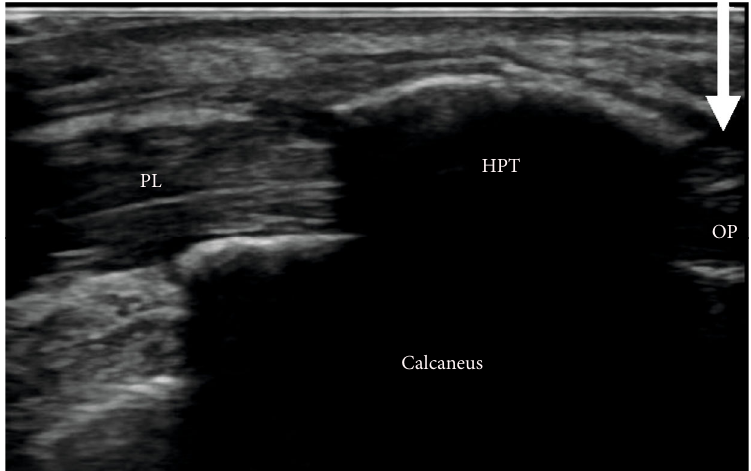
Figure 4: Dynamic ultrasonographic image con fi rmed hypertrophic peroneal tubercle and os peroneum causing impacts. Lidocaine injection was performed in between and os peroneum (white arrow). Abbreviation: PL: peroneus longus; HTP: hypertrophic peroneal tubercle; OP: os